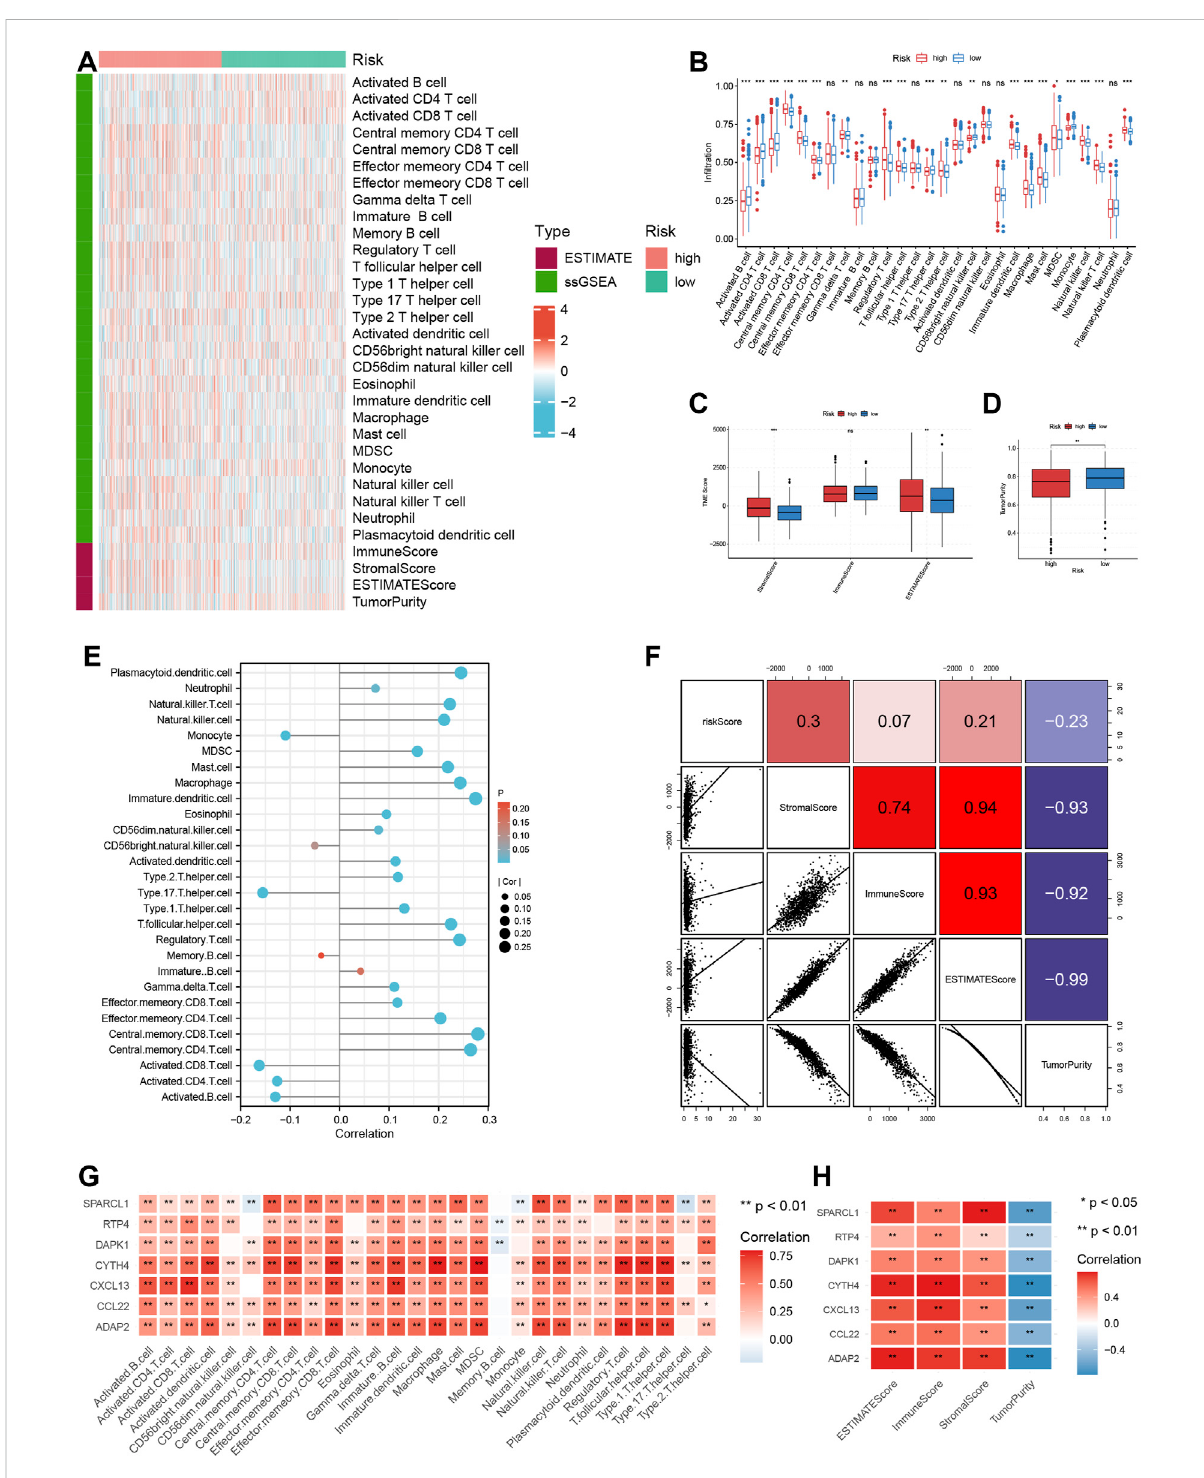
FIGURE 5 Analysis of TME landscape for TRMRG risk score signature. (A) Heatmap showing the immune cell in fi ltration level, TME score and tumor purity between high and low risk patients. (B – D) Box plot comparing differences in (B) immune cell in fi ltration level (C) TME scores and (D) tumor purity between high and low risk patients. (E,F) Pearson correlation analysis of the risk score with (E) immune cell in fi ltration levels, (F) TME scores and tumor purity. (G,H) Pearson correlation analysis of expressions of individual TRMRG with (G) immune cell in fi ltration levels, (H) TME scores and tumor purity. Statistical Signi fi cance: * p < 0.05; ** p < 0.01; *** p < 0.001; ns: not signi fi